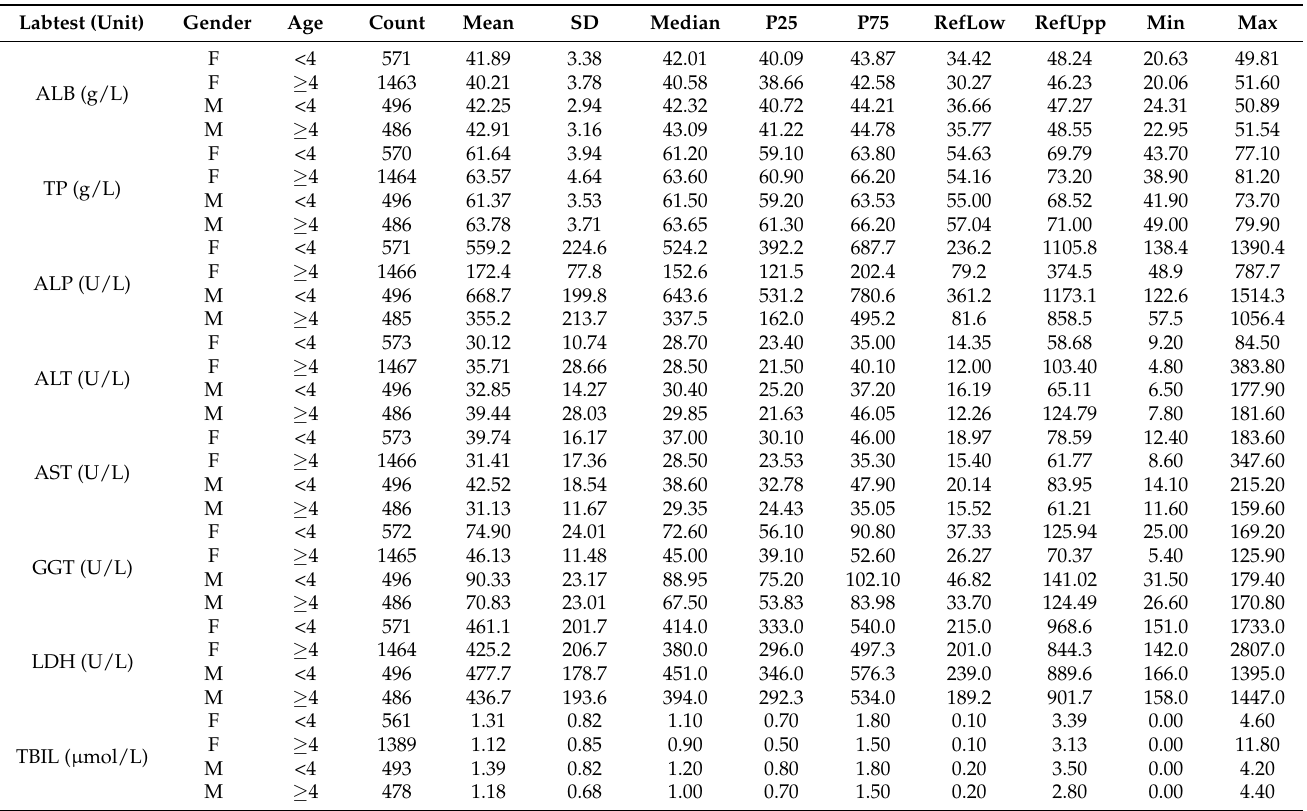
Table 3. Serum biochemical reference intervals and percentiles in the rhesus macaques excluding